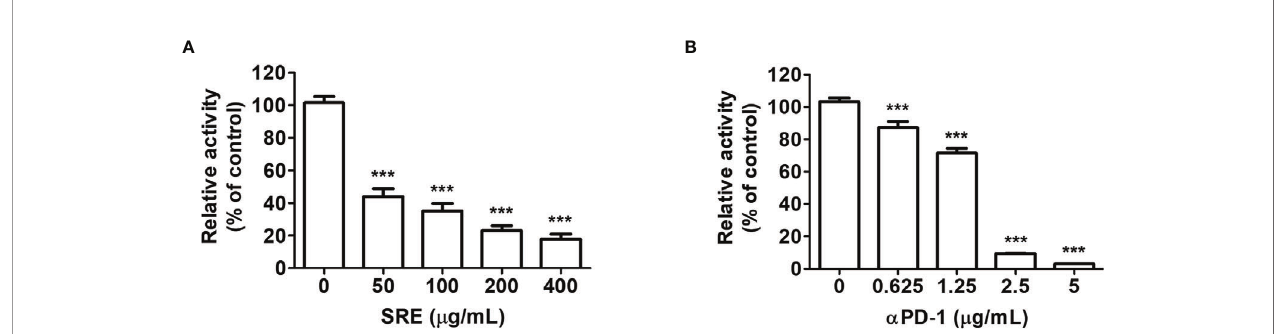
FIGURE 1 | Sanguisorbae Radix extract (SRE) blockade of programmed death-1/programmed death-1 ligand (PD-1/PD-L1) interaction using competitive ELISA. The competitive ELISA was performed using the PD-1/PD-L1 inhibitor screening assay kit. The indicated concentrations of SRE (A) and anti-PD-1 antibodies ( a PD-1) (B) were treated on plates coated with PD-L1, then incubated with biotin-labeled PD-1. Data are presented as the mean ± SD. *** p < 0.001 compared to